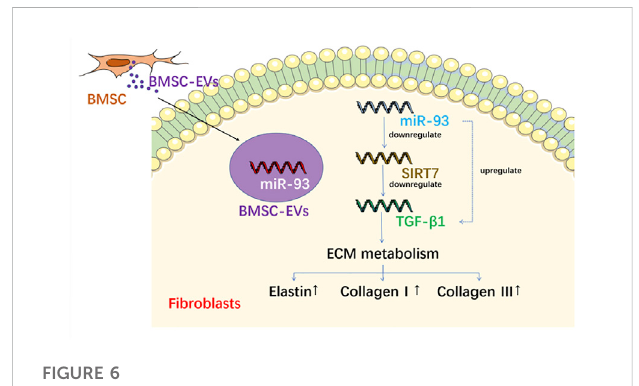
FIGURE 6 The mechanism of EVs from BM-MSC on fi